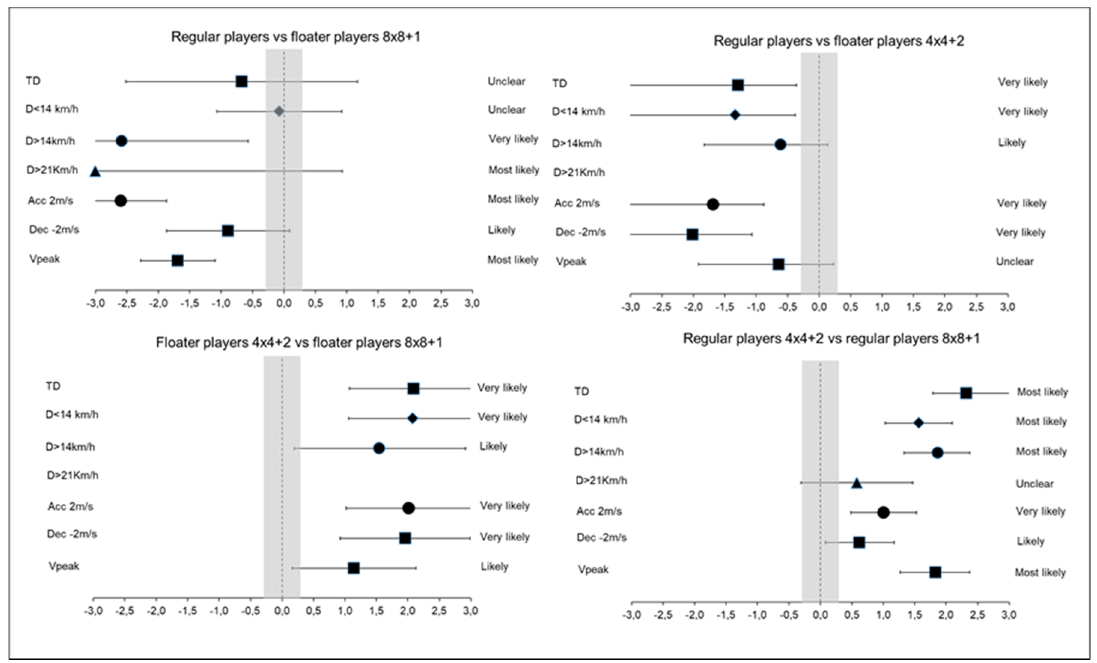
Figure 1. Forest plot showing the effect sizes (with associated confidence intervals) for the physical demand comparisons between regular players and floater players in SSGs. The shaded area, spanning 0.2 to − 0.2, represents nonmeaningful effect size. TD: total distance D: Distance; Acc: Acceleration; Dec: Deceleration; Vpeak: Peak velocity.